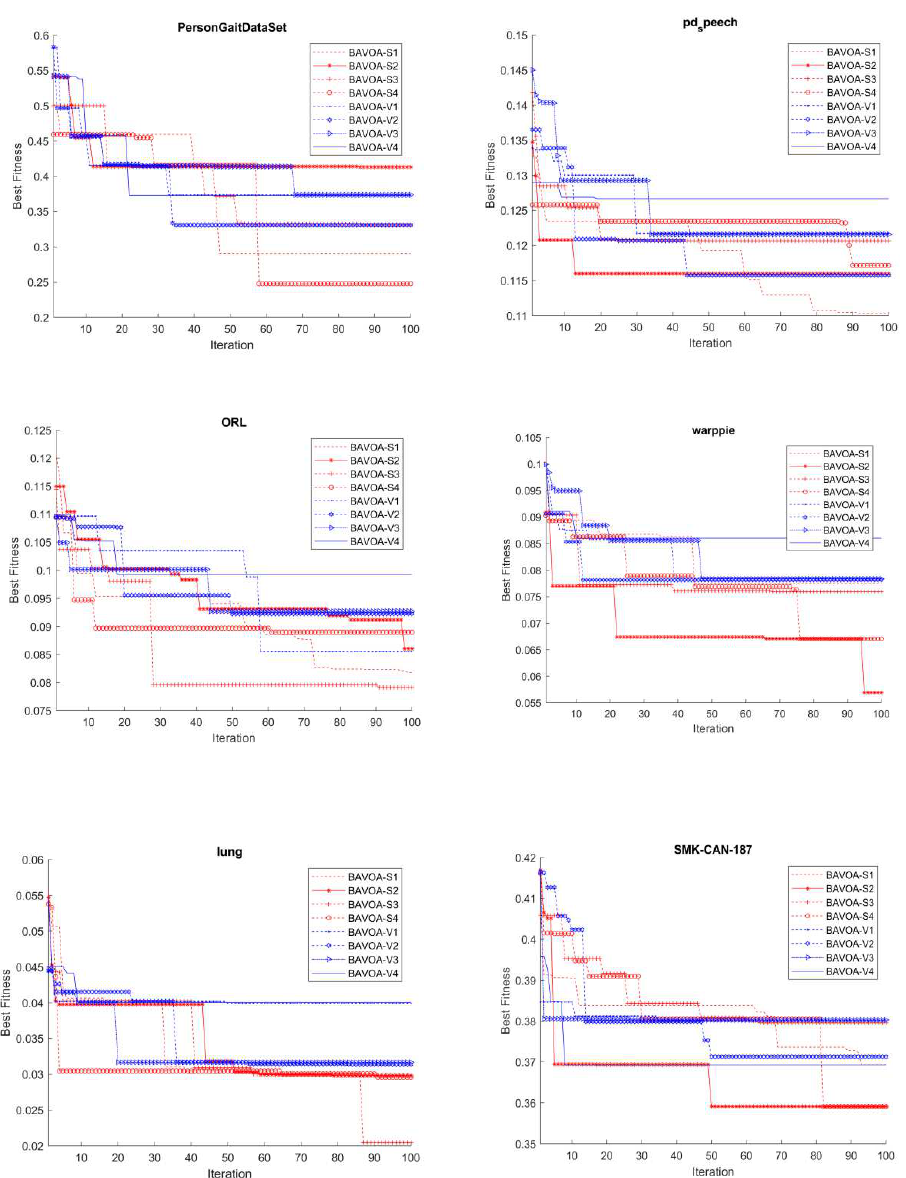
Figure 14. Comparison of the convergence of S-shaped- and V-shaped-based methods on the fifth six data sets. data